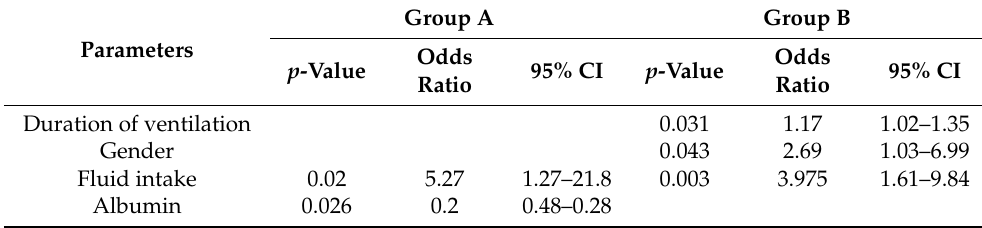
Table 3. Co-variables in the regression analysis for groups A and